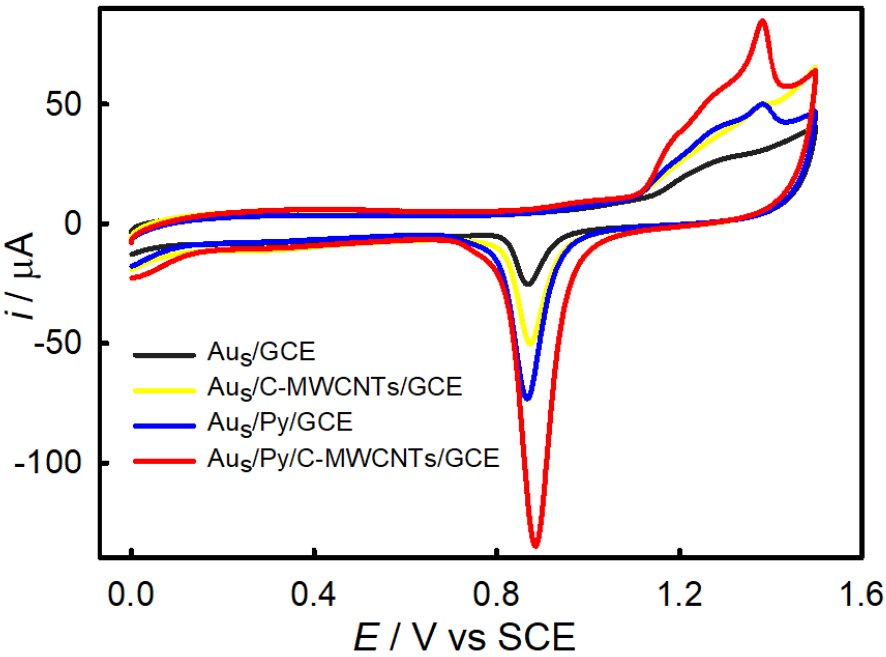
Figure 3. CV curves of Au /GCE , Au s /C-MWCNTs/GCE, Au s /Py/GCE, and Au s /Py/C-MWCNTs/GCE (5 min gold staining) in 0.1 M aqueous H 2 SO 4 . Scan rate: 50 mV s − 1 . The modified electrodes were characterized by SEM and EDX, as shown in Figure 4. The Py/GCE shows a rather smooth surface. The Py/C-MWCNTs/GCE shows random stacking of obvious nanotubes (C-MWCNTs). The AuNPs/Py/C-MWCNTs/GCE shows obvious and uniform distribution of AuNPs on the GCE substrate and C-MWCNTs. The AuNPs/Py/C-MWCNTs/GCE shows an increased size and number of Au s . N and Au elements are found on the AuNPs/Py/C-MWCNTs/GCE, the amount of Au is increased after gold staining.